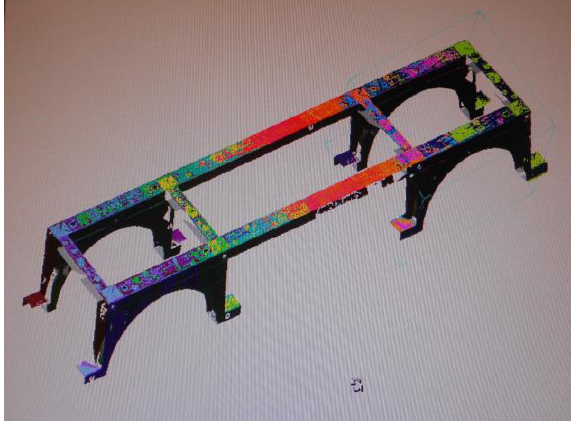
Figure 6. Calibration